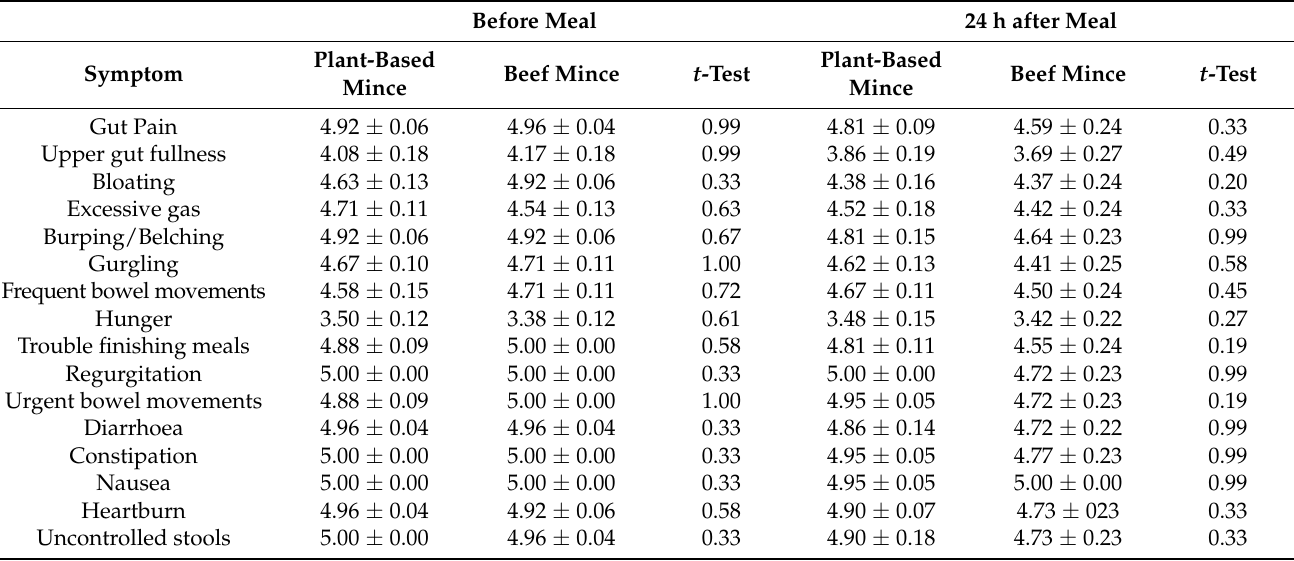
Table 2. Symptoms of gut health, as assessed by a validated gut health score questionnaire, in the 24 h before and 24 h after consuming the plant-based mince and beef mince pasta